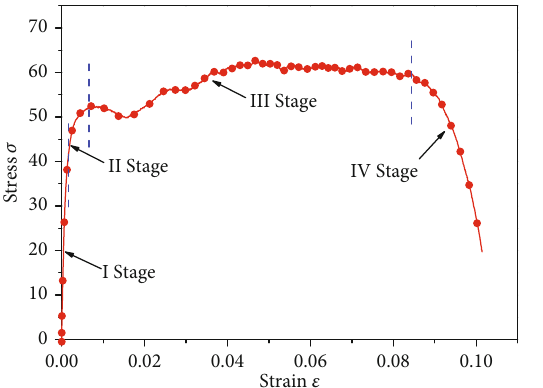
Figure 10: The typical stress-strain curve of mudstone under impact loading.